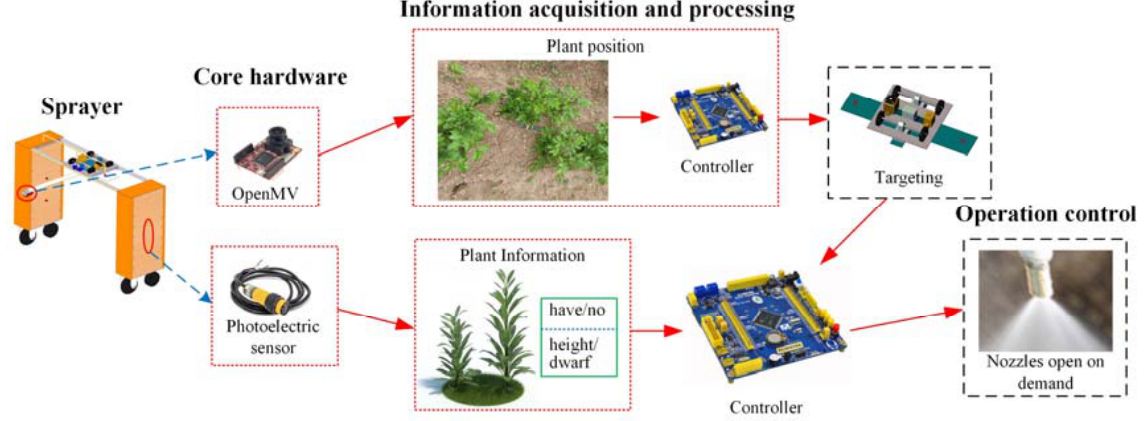
Figure 8. The process of targeted and variable spray.